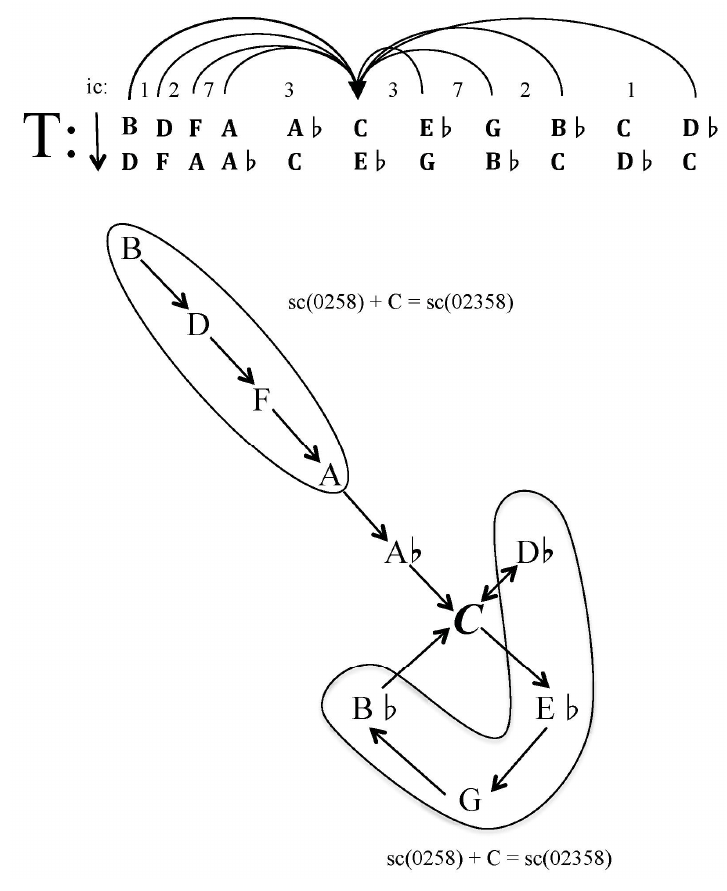
Figure 9. Kinematic analysis of Many Many Cadences , measures 25–9.